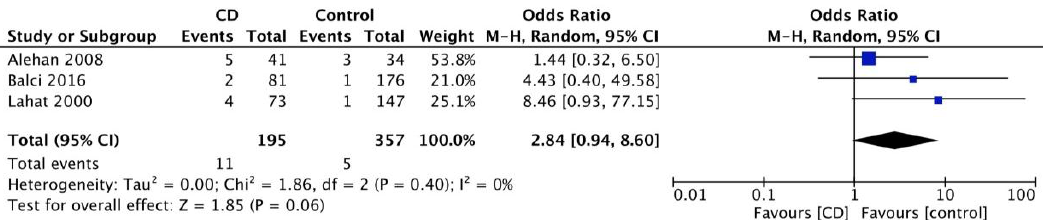
Figure 7. Meta-analysis results as illustrated in the forest plot regarding the odds of having migraine in children with coeliac disease compared to controls.